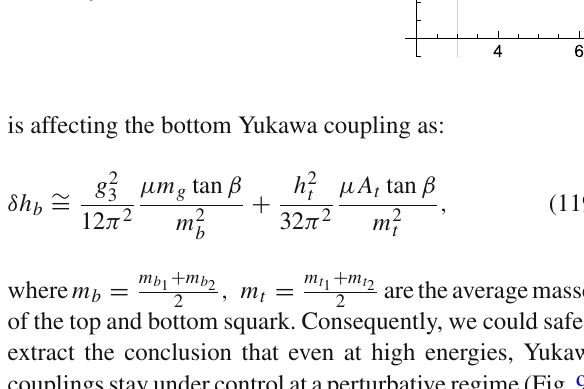
Fig. 9 Yukawa evolution for the following parameters SUSY parameters m g = 2 TeV ,μ = 0 . 5 TeV , tan β = 58 , m t = 3 TeV , h t ( 0 ) = 0 . 94 , h b ( 0 ) = 0 . 8 , h τ ( 0 ) = 0 . 48 . The dashed lines are the Yukawa without the vector like families where they deviate for tan β > 50